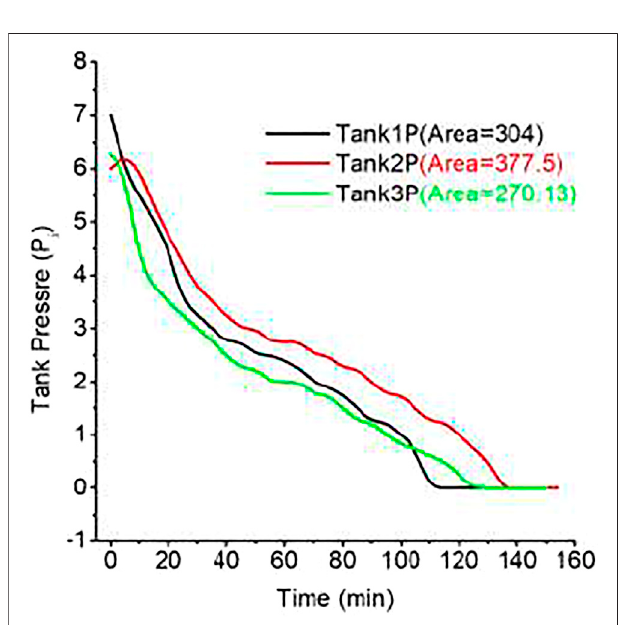
FIGURE4| HydrogendischargecurvesofMHtanksat40 ° Cand500-W